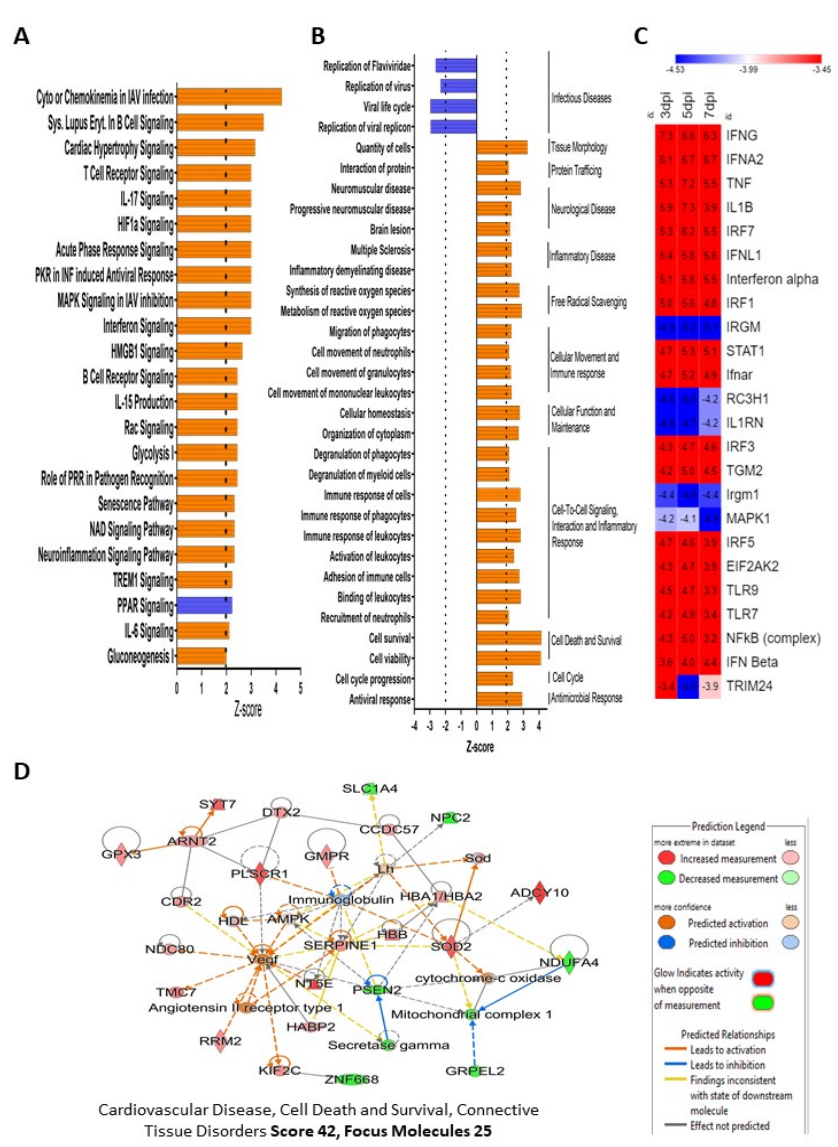
Figure 3. IPA-predicted activation and inhibition of bio-functions, canonical pathways, protein– protein networks, and upstream molecules after ZIKV infection in HSerC. ( A ) Top-most canonical pathways predicted to be significantly activated or inhibited by IPA at 5 days post ZIKV infection. ( B ) Top bio-functions and predicted activation or inhibition Z-scores indicated at 5 dpi. Activation is indicated by a positive Z-score and the inhibited bio-functions are indicated by negative Z-scores. ( C ) The top 25 upstream regulators, predicted to be affected at 3, 5 and 7 dpi after ZIKV infection in HSerC. Red indicates up ‐ regulation, blue indicates down ‐ regulation. Numbers in boxes show the significance of alteration measured by Z ‐ score. ( D ) The most affected protein networks at 5 dpi by ZIKV infection in HSerC. Red and green represent up ‐ regulation and down ‐ regulation, respectively; gray proteins denote that they were recognized in the present study, but not significantly regulated; colorless proteins interact with molecules in the network, but were not identified in our study. Abbreviations. dpi = Days post infection.